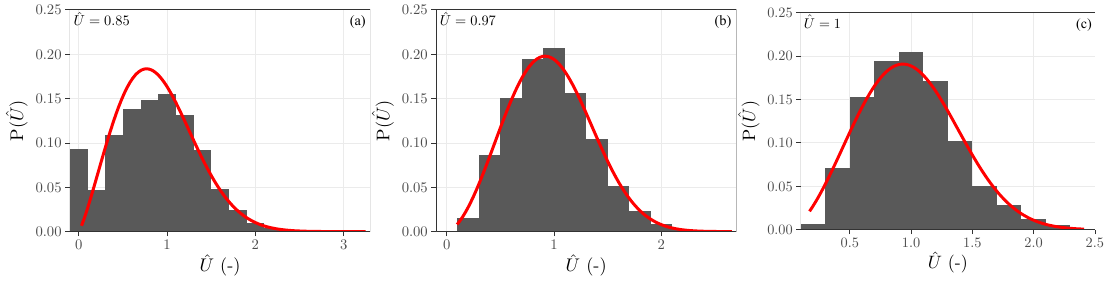
Figure 4. Histogram of the observed all-sector normalized wind speed ˆ U (see text) at mast 1 at 59ma.g.l. without any filtering (a) , after selecting data with QC = 1 with 59% of the data (b) , and during the times when all masts simultaneously had QC = 1 with 16% of the data (c) . The red line denotes the Weibull distribution that WAsP fits for this